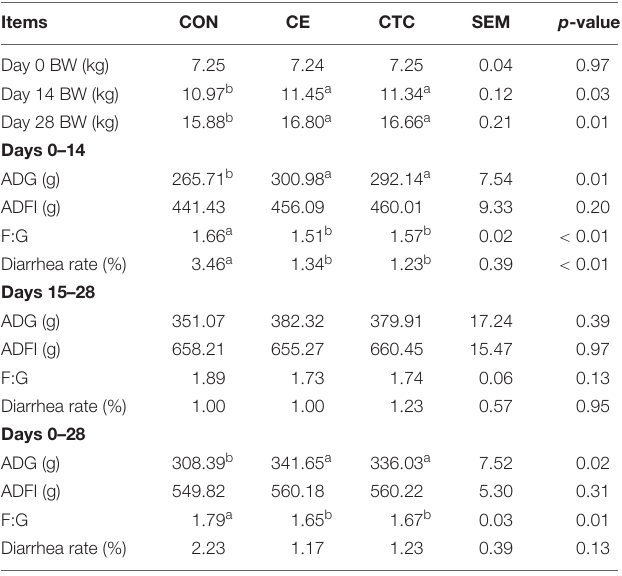
TABLE 2 | Effect of CE on growth performance and diarrhea rate of weaned piglets.